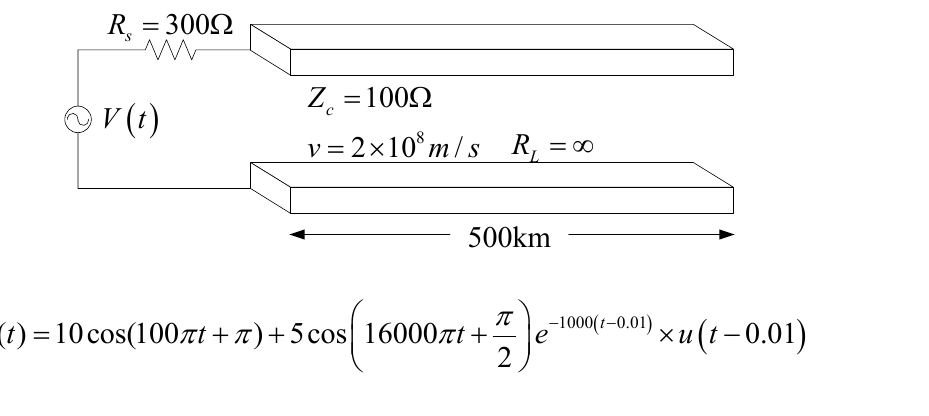
Figure 11. The simulation